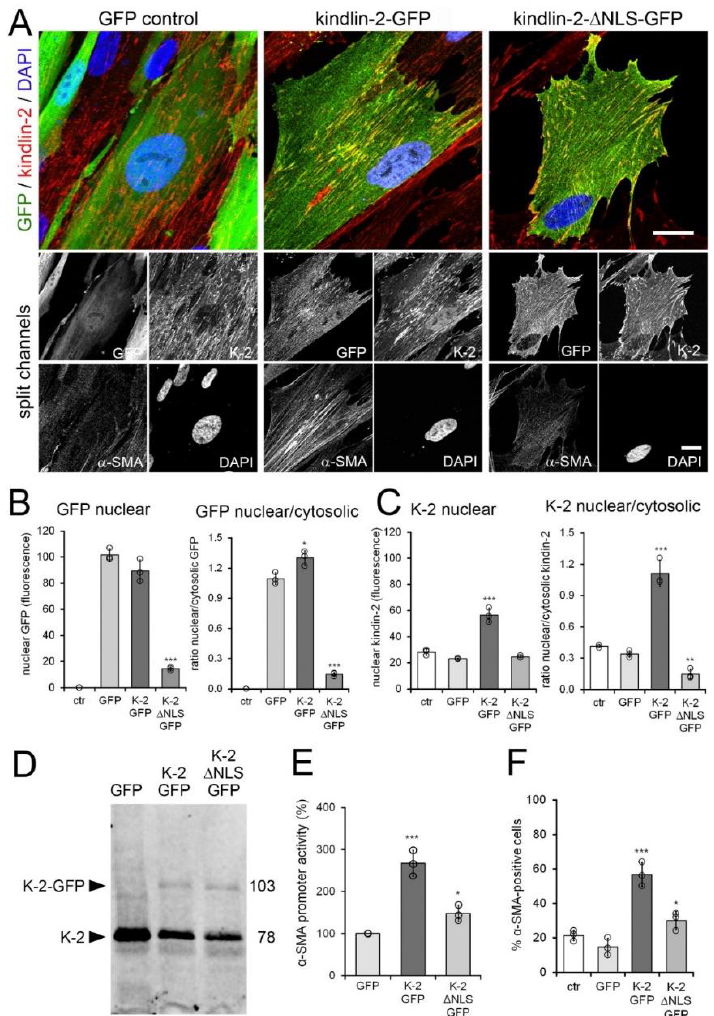
Figure 6. Kindlin-2 overexpression promotes myofibroblast activation. Human MRC-5 fibroblasts were transiently transfected with kindlin-2 (K-2)-GFP, a kindlin-2-GFP mutant lacking the putative nuclear localization sequence (NLS) (kindlin-2- ∆ NLS-GFP) and GFP vector control (ctr). Cells were analyzed after 48 h by ( A , B ) confocal immunofluorescence co-staining for GFP (green), α -smooth muscle actin ( α -SMA) (greyscale), kindlin-2 (red), and 4′,6 -diamidino-2-phenylindole (DAPI) (blue) and ( C , D ) quantitative immunoblotting against kindlin-2. Scale bar: 25 µ m. ( B ) Levels of nuclear and perinuclear (cytosolic) GFP signals were quantified from GFP confocal immunofluorescence images to calculate levels of nuclear GFP and ratios of nuclear / cytosolic GFP only in transfected fibroblasts (green). ( C ) The same was done for kindlin-2 signal, comprising transfected and endogenous kindlin-2. ( D ) Western blot for kindlin-2. ( E ) MRC-5 were additionally transfected with firefly luciferase promoter under full length α -SMA promoter control; signal was first normalized to renilla luciferase and then to GFP control. ( F ) The percentage of α -SMA-positive cells was quantified by manually counting α -SMA stress fiber-positive fibroblasts in the GFP-positive fraction ( ≥ 10 cells / image, ≥ 5 images / experimental condition). Shown are mean values from at least three independent experiments (data points) ± SD (* p < 0.05, ** p < 0.01, *** p < 0.005, using ANOVA followed by a post-hoc Tukey’s multiple comparison test).